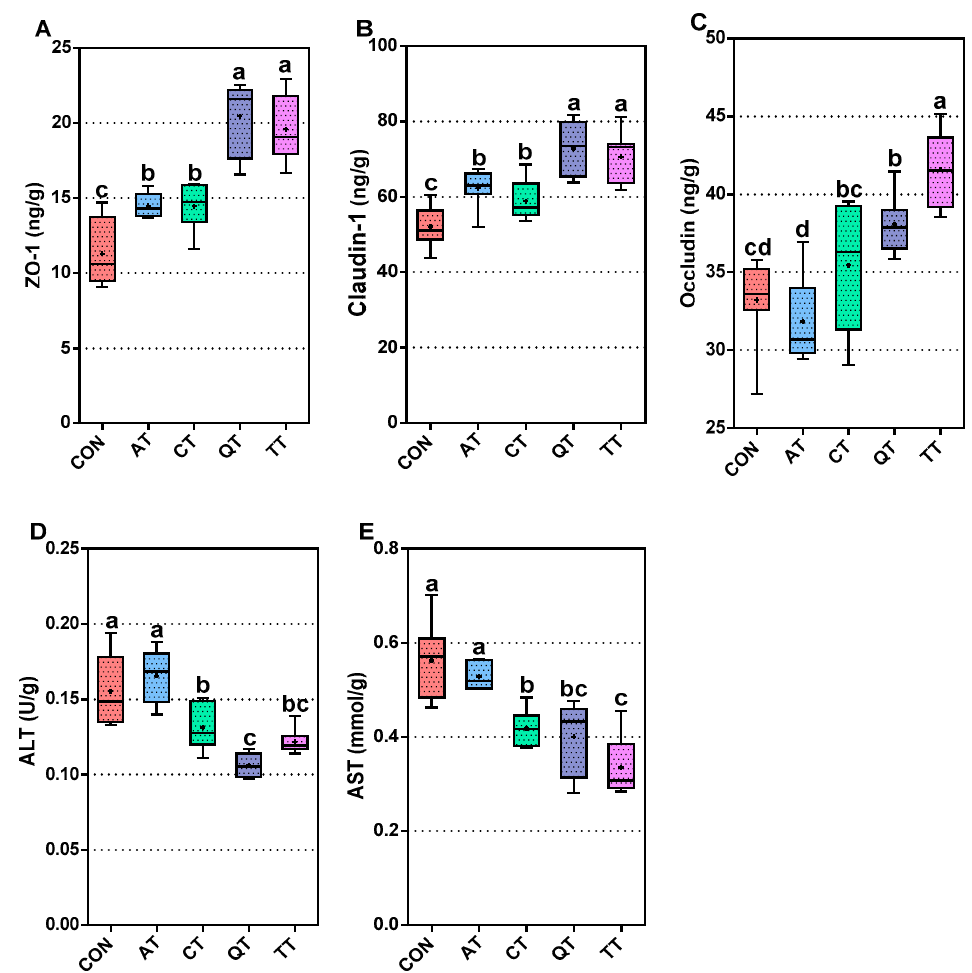
Figure 3. Effects of adding different tannins to the diet on the intestinal mucosal barrier and liver function. ( A ) Zonula occludens-1, ZO-1; ( B ) claudin-1; ( C ) occludin; ( D ) alanine aminotransferase test; ALT ( E ) aspartate aminotransferase test; AST. Different letters (a, b, c and d) indicate significant differences ( p < 0.05), while the same letter indicates no significant differences ( p > 0.05). CON, control; AT, Acacia mearnsii tannin; CT, Castanea sativa tannin; QT, Schinopsis lorenzii tannin; TT, Caesalpinia spinosa tannin.